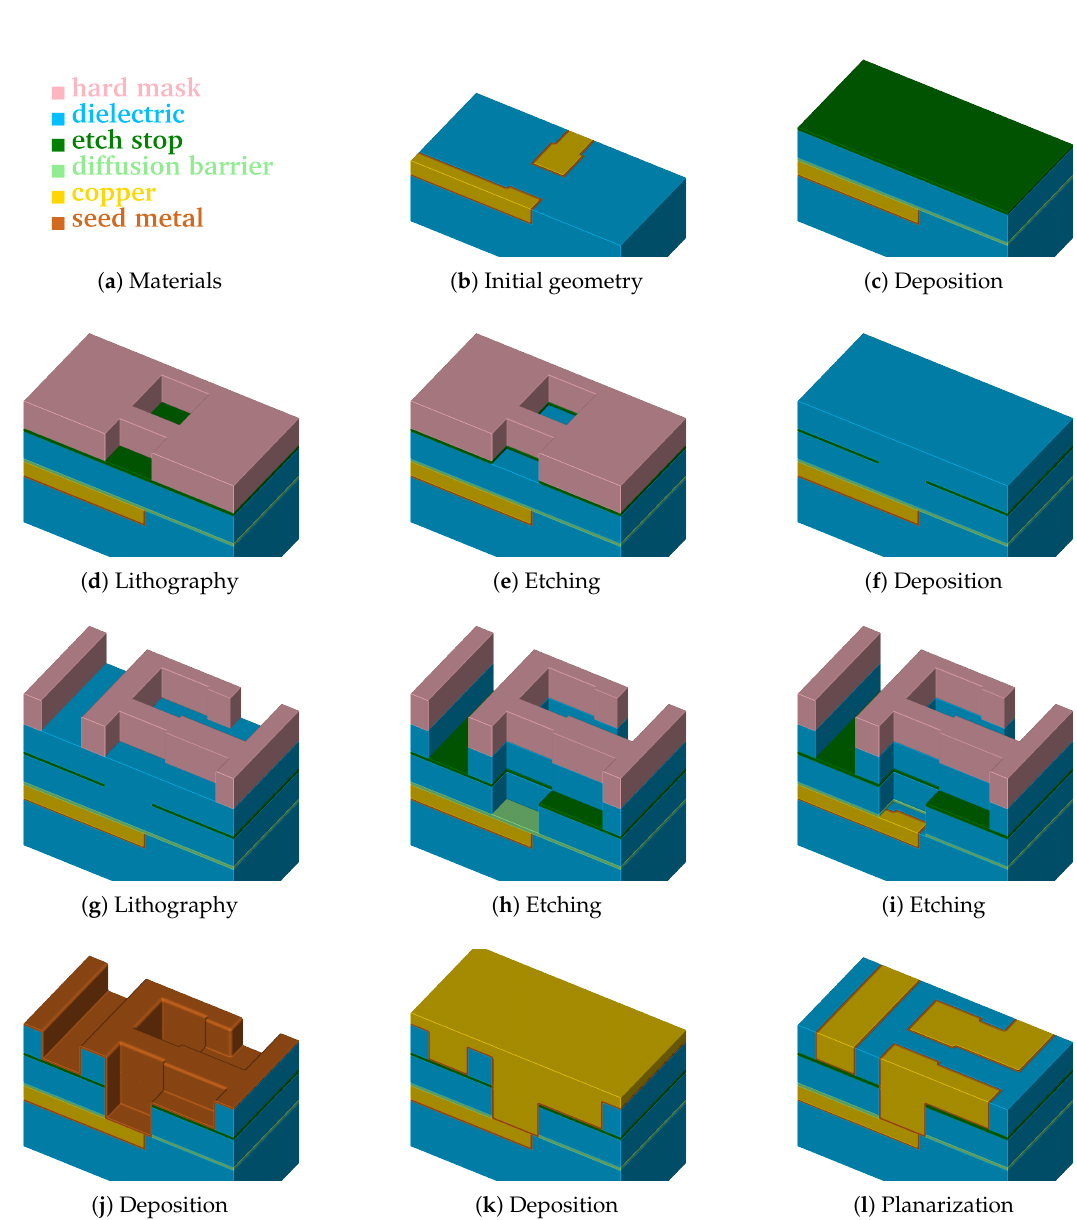
Figure 2. Individual processing steps for the self-aligned Dual-Damascene process. The material legend is shown in ( a ). ( b – l ) illustrate all processing steps to create a metalization layer on top of an exiting metalization layer (the square domain is clipped along one axis for better visibility). First row ( b , c ): initial patterned planar conductor and deposition of three layers: a diffusion barrier, a dielectric material, and an etch stop material. Second row ( d – f ): patterning of the etch stop layer (at the position of the vias) including the deposition of the second dielectric layer. Third row ( g – i ): patterning of the dielectric layers (vias and lines) including opening of the diffusion barrier layer around at the position of the via. Last row ( j – l ): copper metalization including the deposition of a metal seed layer and chemical-mechanical planarization after the copper